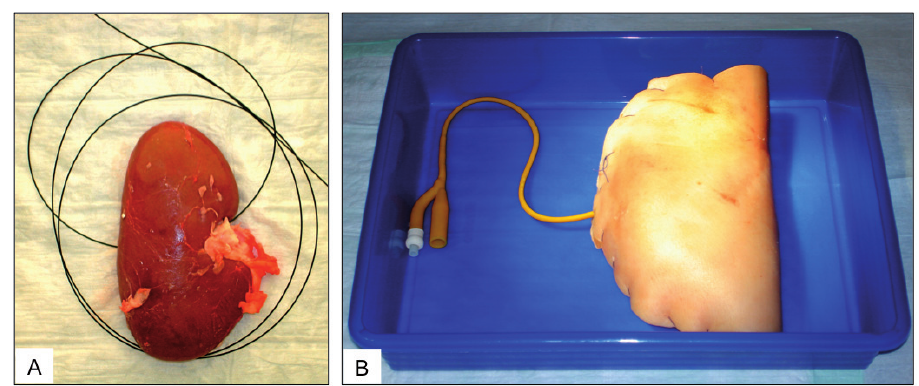
Figure 3 - Guide-wire for easy access to the renal pelvis (A) and wrapped organ model, closed by running sutures, in the plastic tray for subsequent training (B).